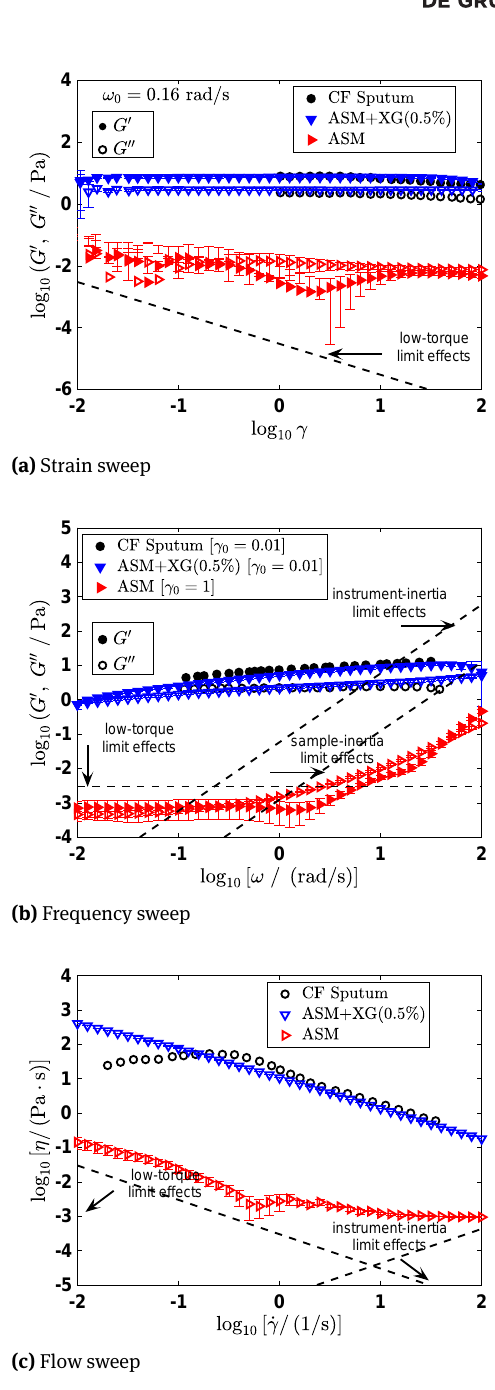
Figure 3: Comparison of rheological properties of ASM and ASM+XG(0.5%) to CF sputum from Dawon et al. [15]. (a) The strain- dependent elastic modulus ( G ′ , closed symbols) and viscous mod- ulus ( G ′′ , open symbols). Strain sweeps were completed at a fre- quency ω 0 = 1rad/s . (b) The frequency-dependent elastic modulus ( G ′ , closed symbols) and viscous modulus ( G ′′ , open symbols). Frequency sweeps were completed at a strain of 𝛾 0 = 0.01 for CF sputum and ASM+XG and at a strain of 𝛾 0 = 1.0 for ASM. (c) The apparent shear viscosities as a function of shear